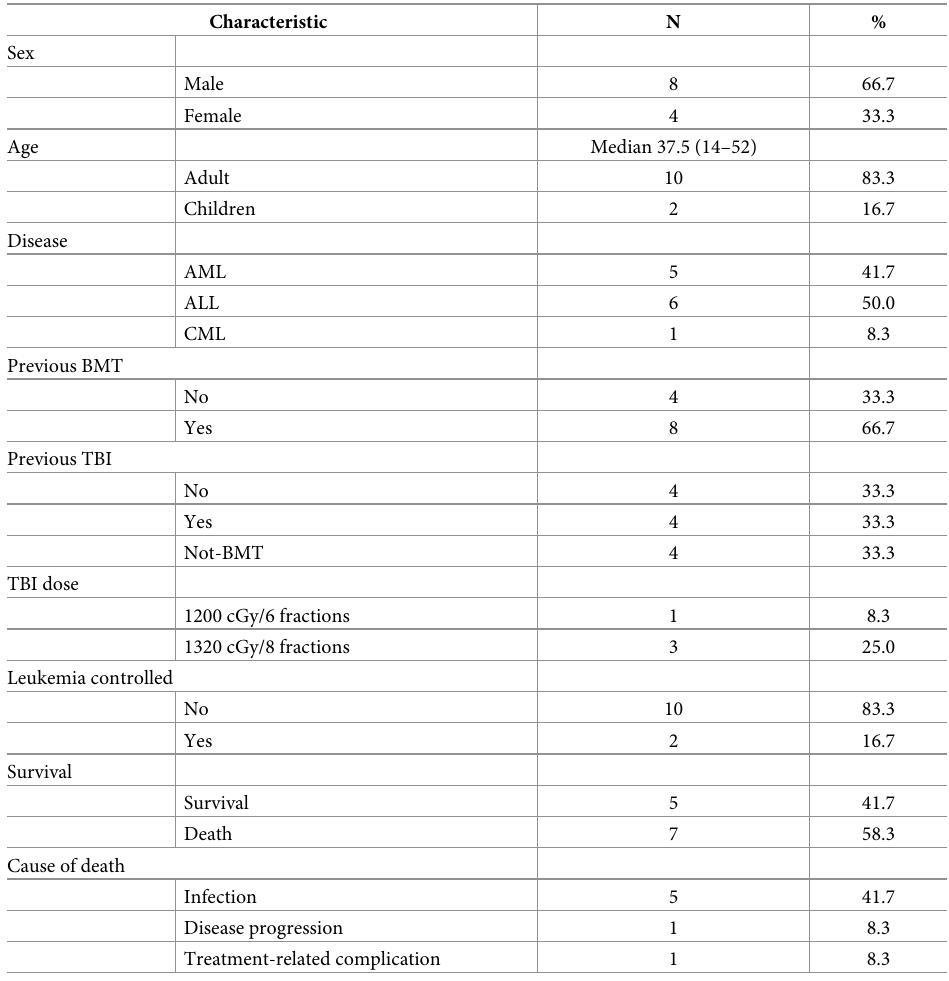
Table 1. Patient characteristics (N = 12). Characteristic N %